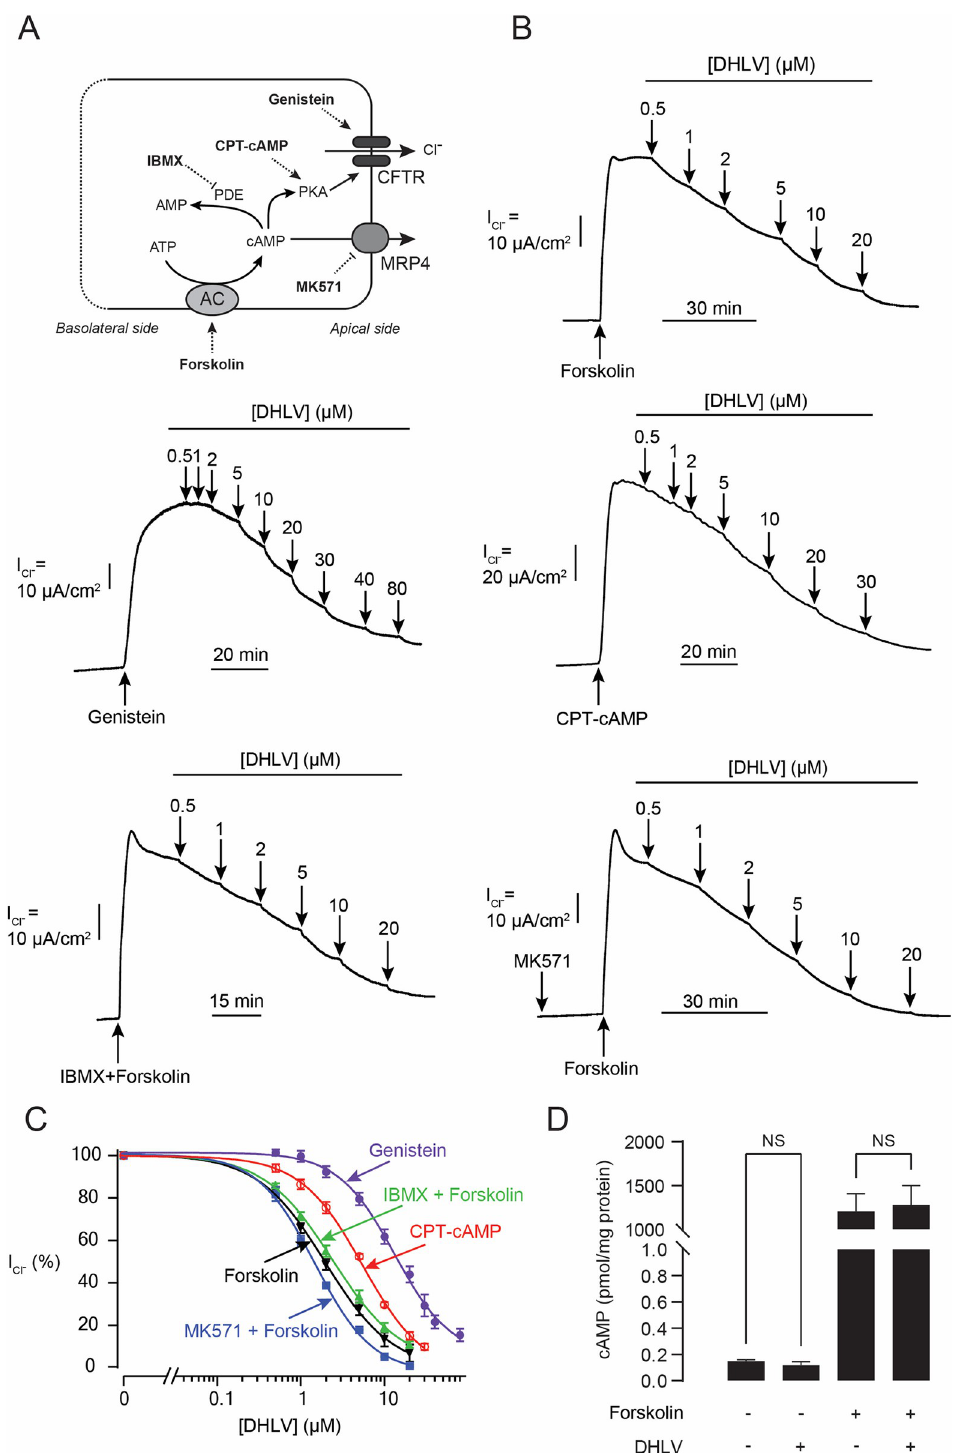
Fig 4. Mechanism of α , β -dehydrolovastatin (DHLV) actions on cAMP-dependent CFTR activity in intestinal epithelial T84 cell monolayers. (A) Schematic diagrams showing the regulatory mechanism of CFTR Cl - channel activity. (B) Effect of DHLV on cAMP-dependent Cl - secretion determined by apical I Cl - analysis induced by forskolin (20 μ M), genistein (20 μ M), or CPT-cAMP (100 μ M). The involvement of phosphodiesterase (PDE) and multidrug- resistance 4 (MRP4) was determined by 15 min pre-treatment with IBMX (1 mM) or MK571 (20 μ M),